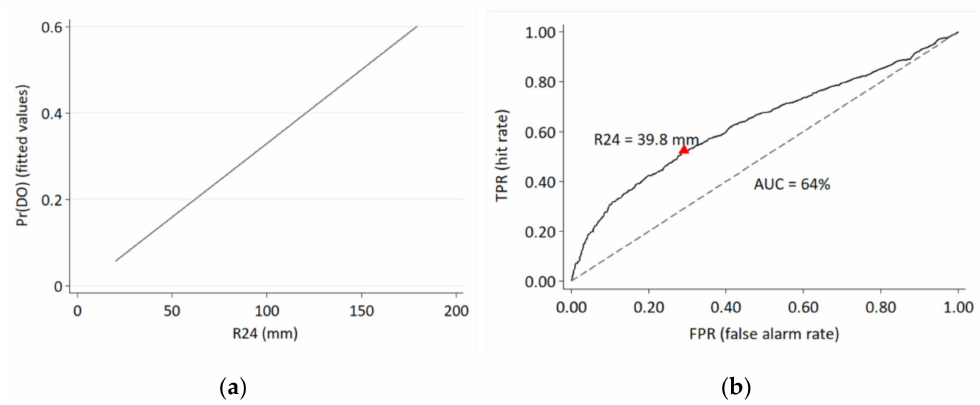
Figure 3. ( a ) Fitted values of DO predicted probability as a function of R24 controlled for the population. ( b ) ROC curve, highlighting the TPR/FPR coordinates related to the AMA optimal R24 threshold given that the difference between TPR and FPR is maximized.